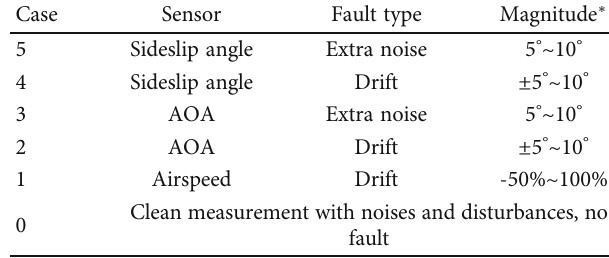
Table 4: ADS fault cases adopted in this paper.